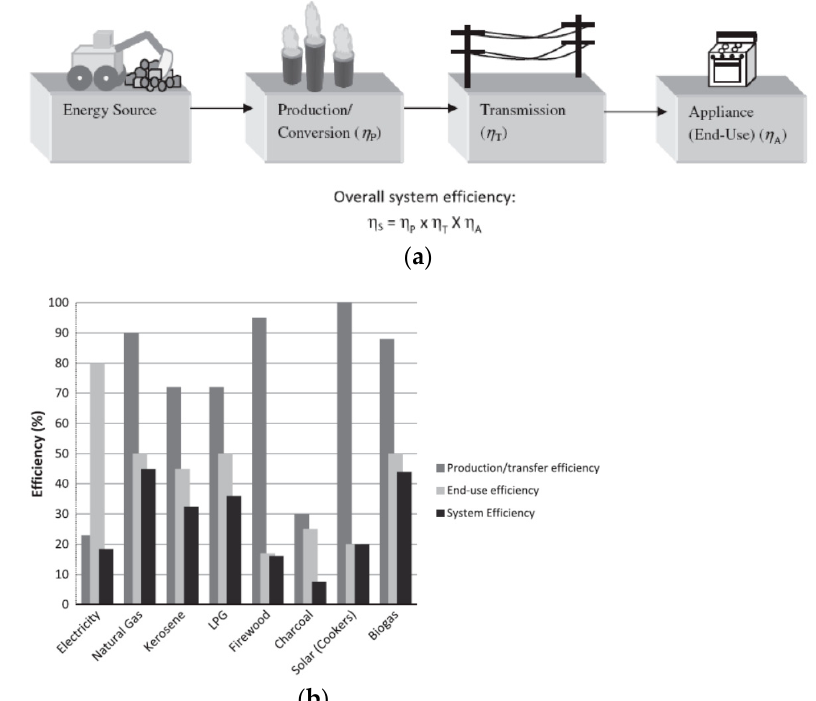
Figure 10. Efficiency of residential cooking appliances using different energy sources: ( a ) System efficiency considerations of utilizing electric appliances. ( b ) Efficiency comparison among cooking appliances [140].